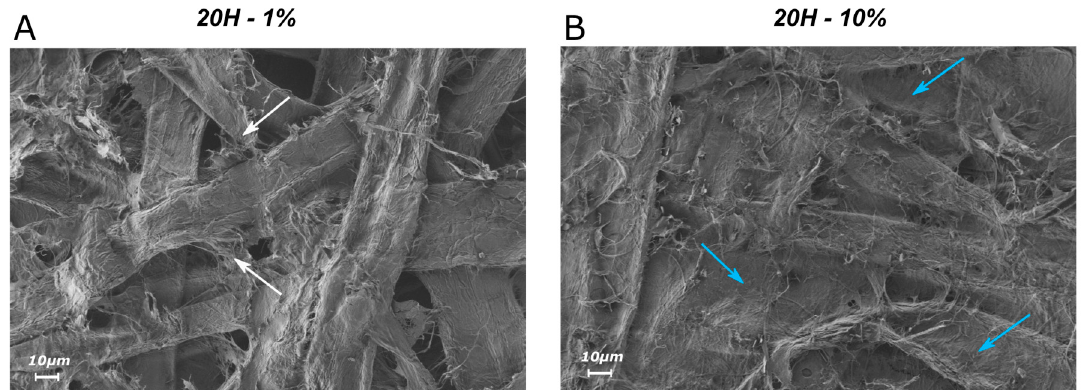
Figure 10. SEM images of the topography of composite handsheets realized with 1% ( A ) and 10% ( B ) of 20H (magnification 500 × , with an acceleration voltage of 0.65 kV). The white arrows indicate zones where small fibrils, being likely the additives, act as connections between two fibers. The blue arrows indicate the areas forming smooth layer of fibrillar elements and entirely composed of additives, supposed to generate a secondary network in the